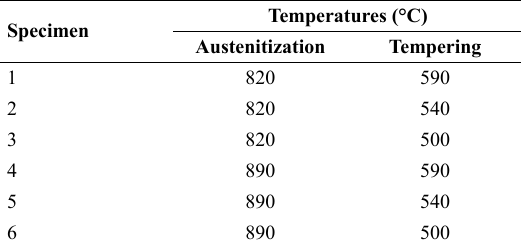
Figure 3. Location of the specimens for tests